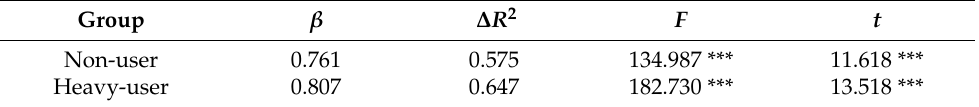
Table 5. Predicting HbR increase for the ‘non-user’ and ‘heavy-user’ groups in BA 9. Group β ∆ R